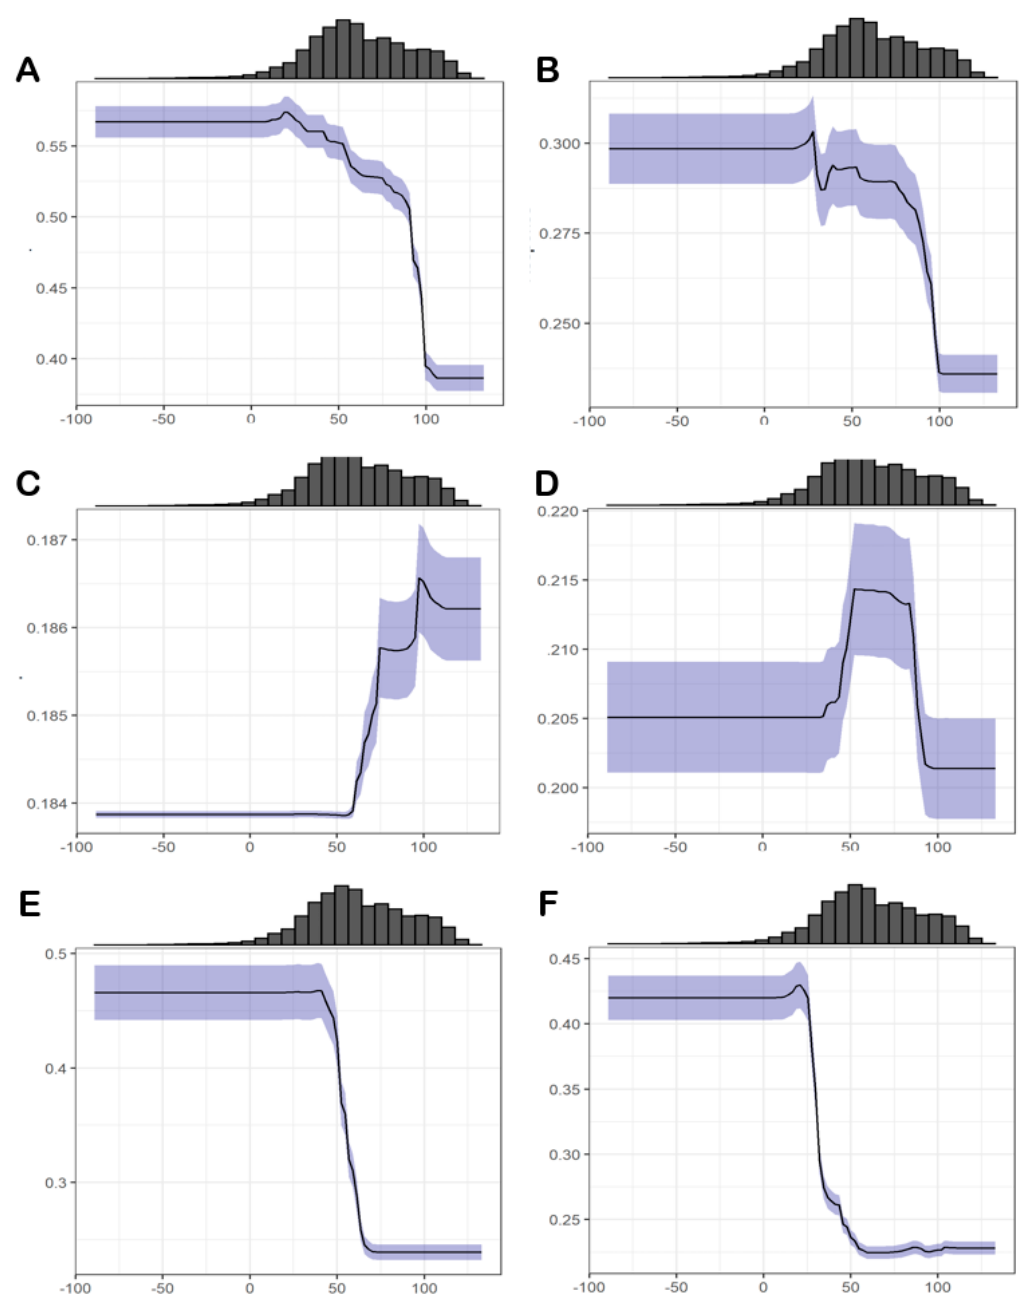
Figure A1. Response curves (average of all GBM models ± ½ std.-deviation) showing habitat suitability variation as function of isothermality values (bio3), for ( A ) MSD, ( B ) PRC, ( C ) T. lusitanica , ( D ) T. ebejeri , ( E ) T. semiaptera and ( F ) T. iberica .